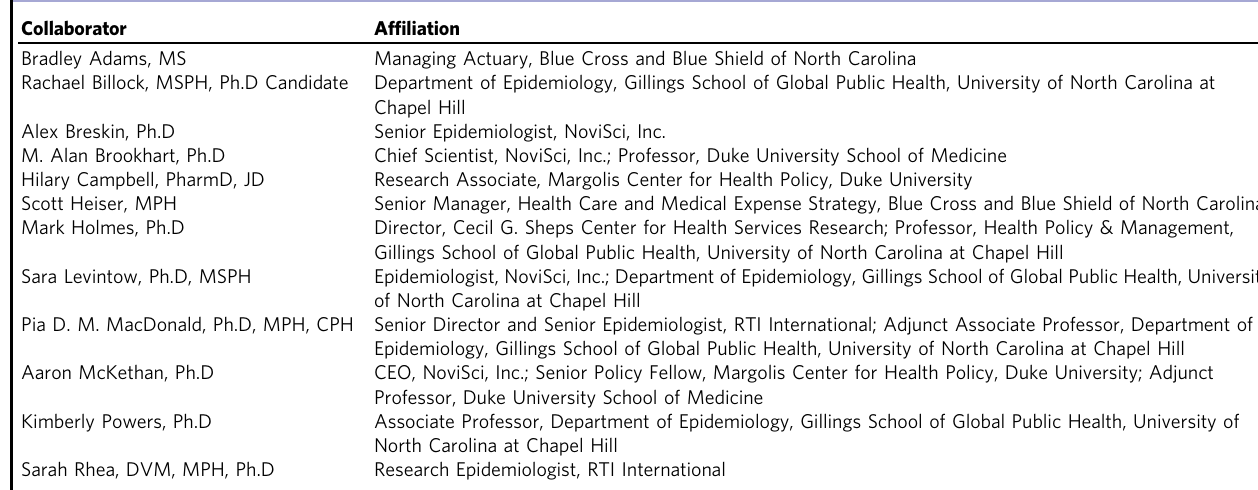
Table 1 Informal Group collaborators and their af fi liations at the time Brief 1 (adapted from North Carolina Collaborative Modeling,